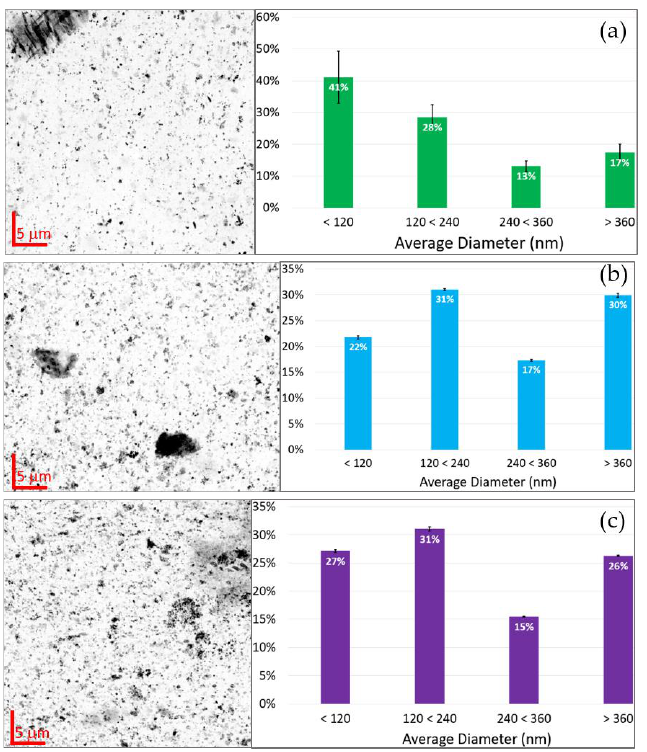
Figure 7. Titanium maps obtained from the nanoXRF analysis of sludge and corresponding particle diameter distribution: ( a ) Casas Grandes Spring (CGP); ( b ) Juarez Spring (JZP); and ( c ) Chihuahua North Spring (CNP).